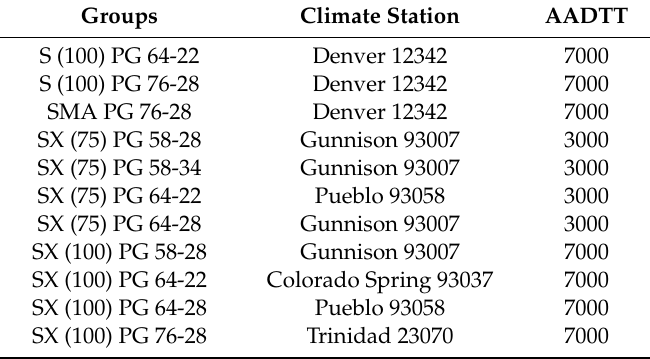
Table 4. Climate station used for di ff erent mixes for the AASHTOWare